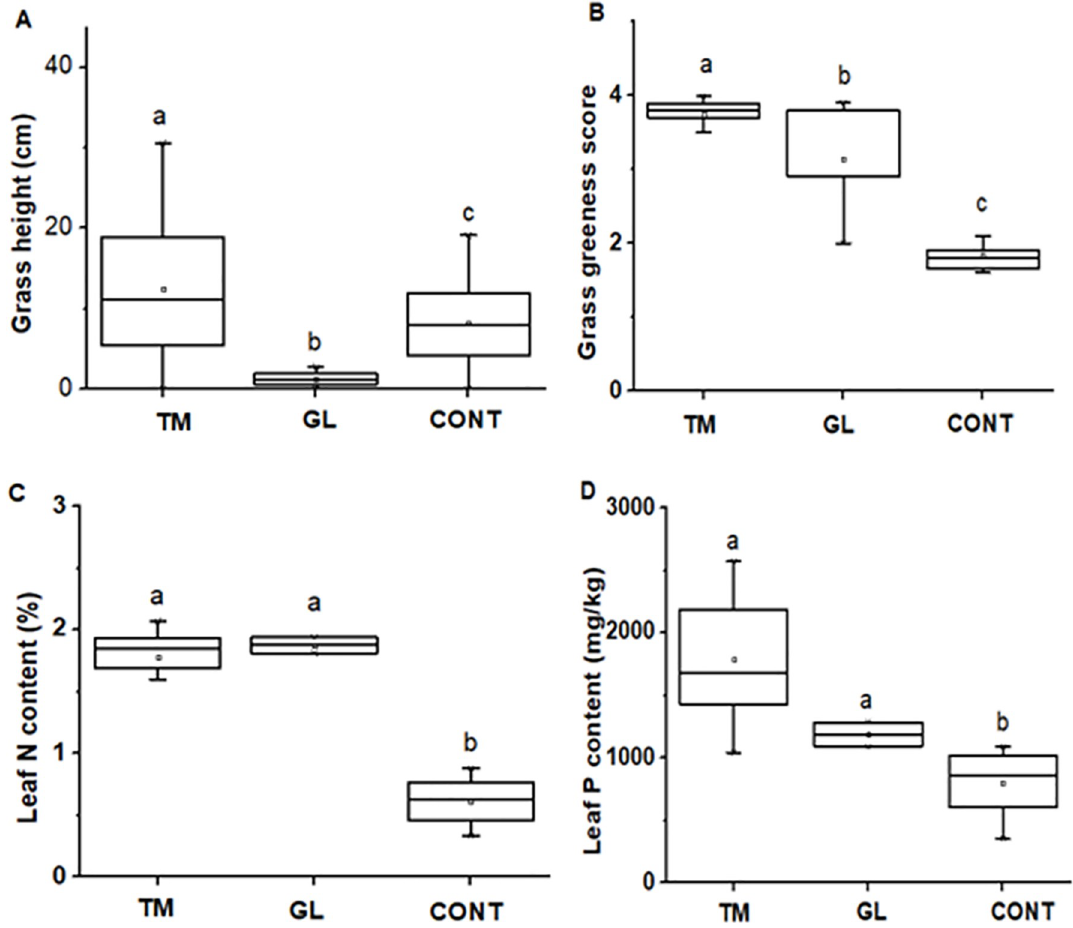
Fig 2. Mean of (A) average Cynodon dactylon grass growth height, (B) average greenness score ranging from scorched grass (1), pale green (2), green (3) and deep green (4), Nitrogen (C) and Phosphorus (D) contents in pots containing soils from termite mounds, grazing lawns and control sites after 61 days of the experiment. N = 30. Termite mounds (TM), control (CONT) and grazing lawns (GL). Boxplots show the mean (a square within boxes) and ranges from 25% and 75% quartile, and the tips of the whiskers indicate standard deviation. Boxes with different letter(s) are significantly different by Fisher LSD at P =